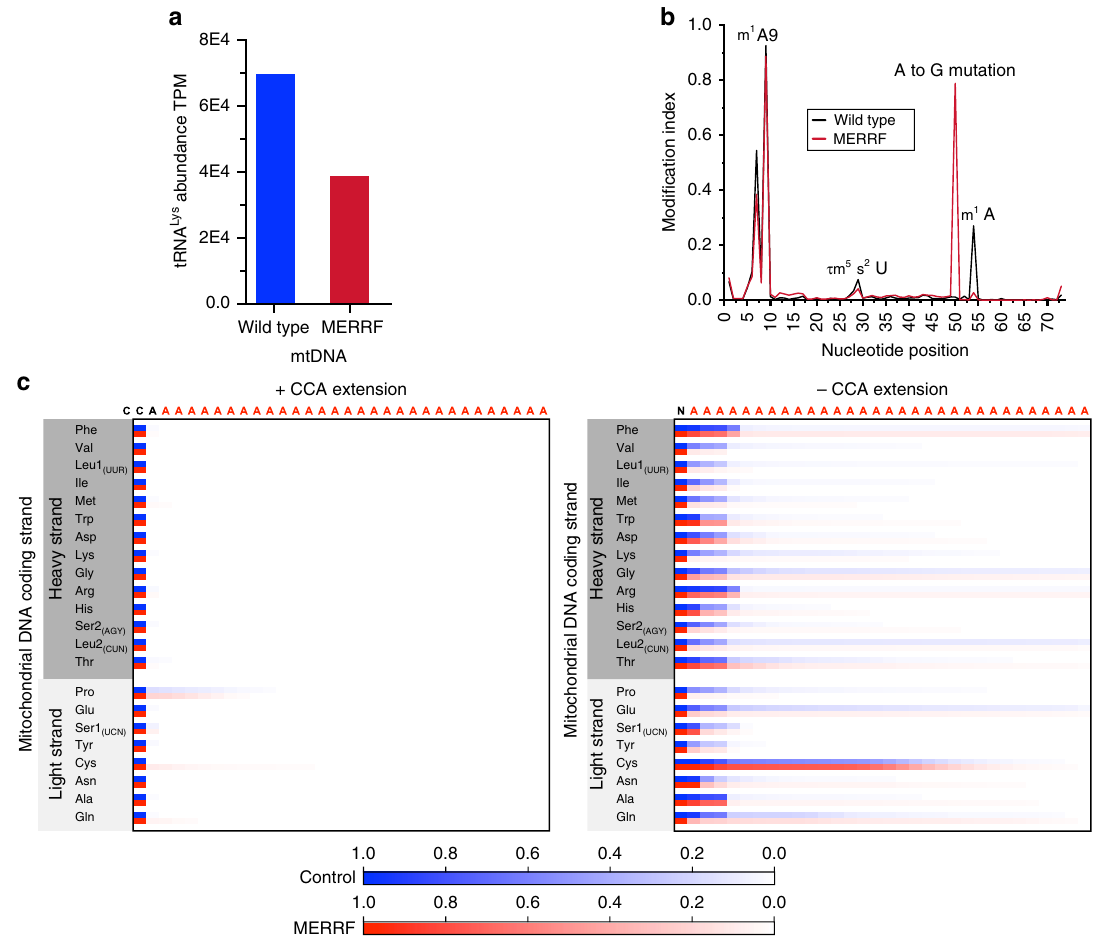
Fig. 3 Novel RNA modi fi cations of tRNA Lys linked to MERRF pathogenesis in human skeletal muscle. a Quanti fi cation of tRNA Lys abundance in skeletal muscle. b A position sequencing plot of tRNA Lys without demethylase treatment from skeletal muscle. c A 3 ′ - position sequencing plot for the frequency of adenylation among mitochondrial tRNAs from skeletal muscle of a control and MERRF